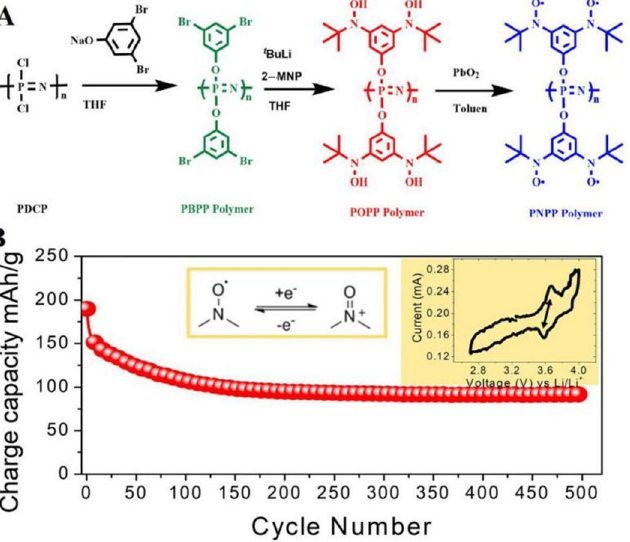
Figure 12. ( A ) synthesis route of the cathode-active material (PNPP); ( B ) capacity retention plot of PNPP cycled at C/2. Taken with permission from [136].